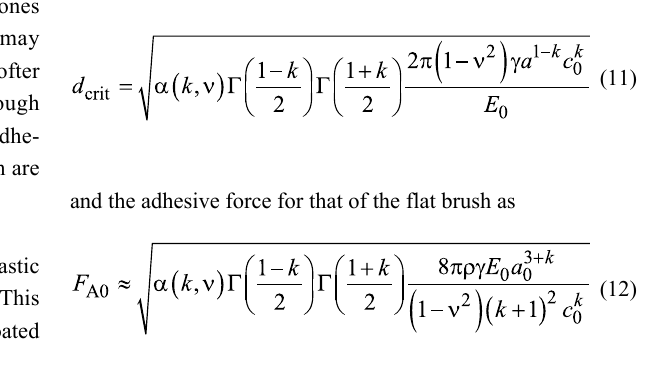
in Figure 5b. It also decreases with increasing l / d crit and practi- cally vanishes at roughness values larger than approximately l / d crit > 1.1. Again, in a dimensionless presentation, the depen- dence is only very weakly sensitive to the fill factor and can be considered, to a good approximation, as universal “master curves”. The results by Johnson in 1974 for an exponential dis- tribution of asperity heights (solid black line) [23], and the results by Fuller and Tabor for a Gaussian asperity height distri- bution (green dashed line) [15] are added in Figure 5b for com- parison, where the relative pull-off forces P / np c and P m / Np c are plotted against σ / δ c , where P is the tensile force per unit area, n the number of asperities per unit area, N the asperity density, p c the critical adhesive force of an individual sphere, σ the standard deviation of the distribution of asperity heights, and δ c the critical separation similar to Equation 6 but for spher- ical